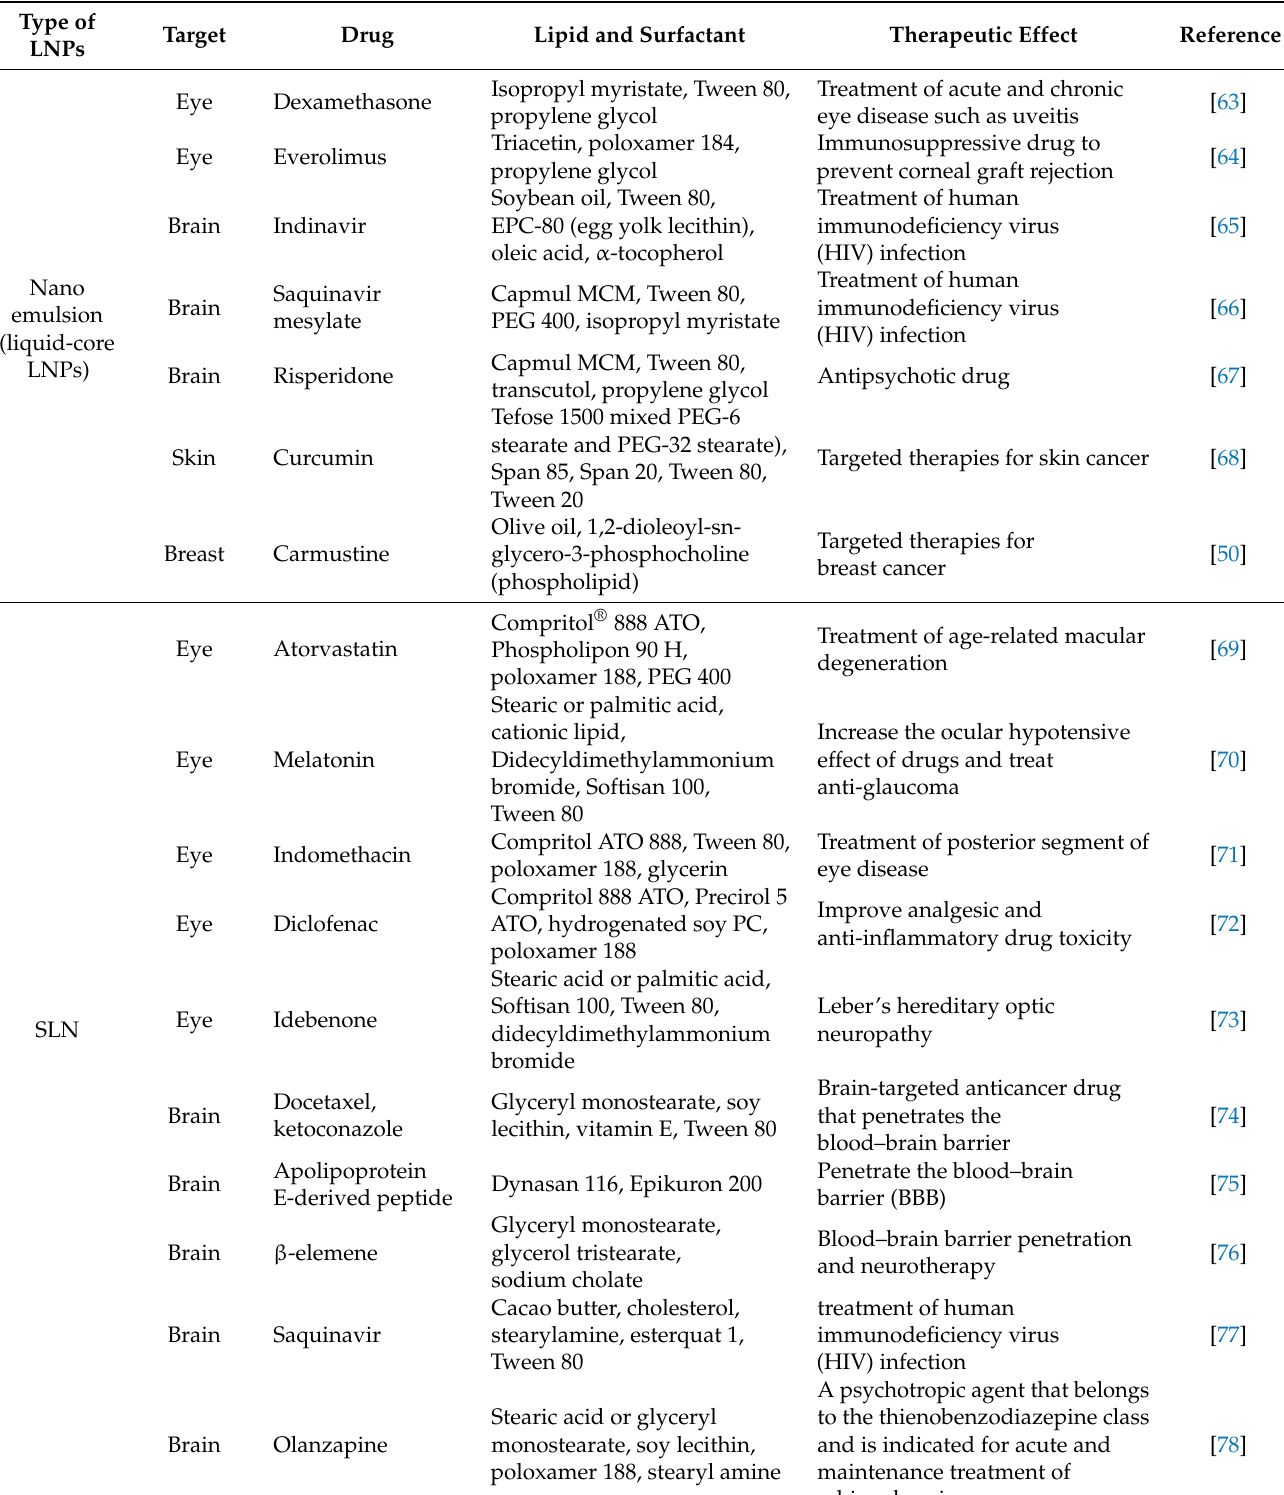
Table 1. Recent lipophilic drug delivery based on various types of lipid